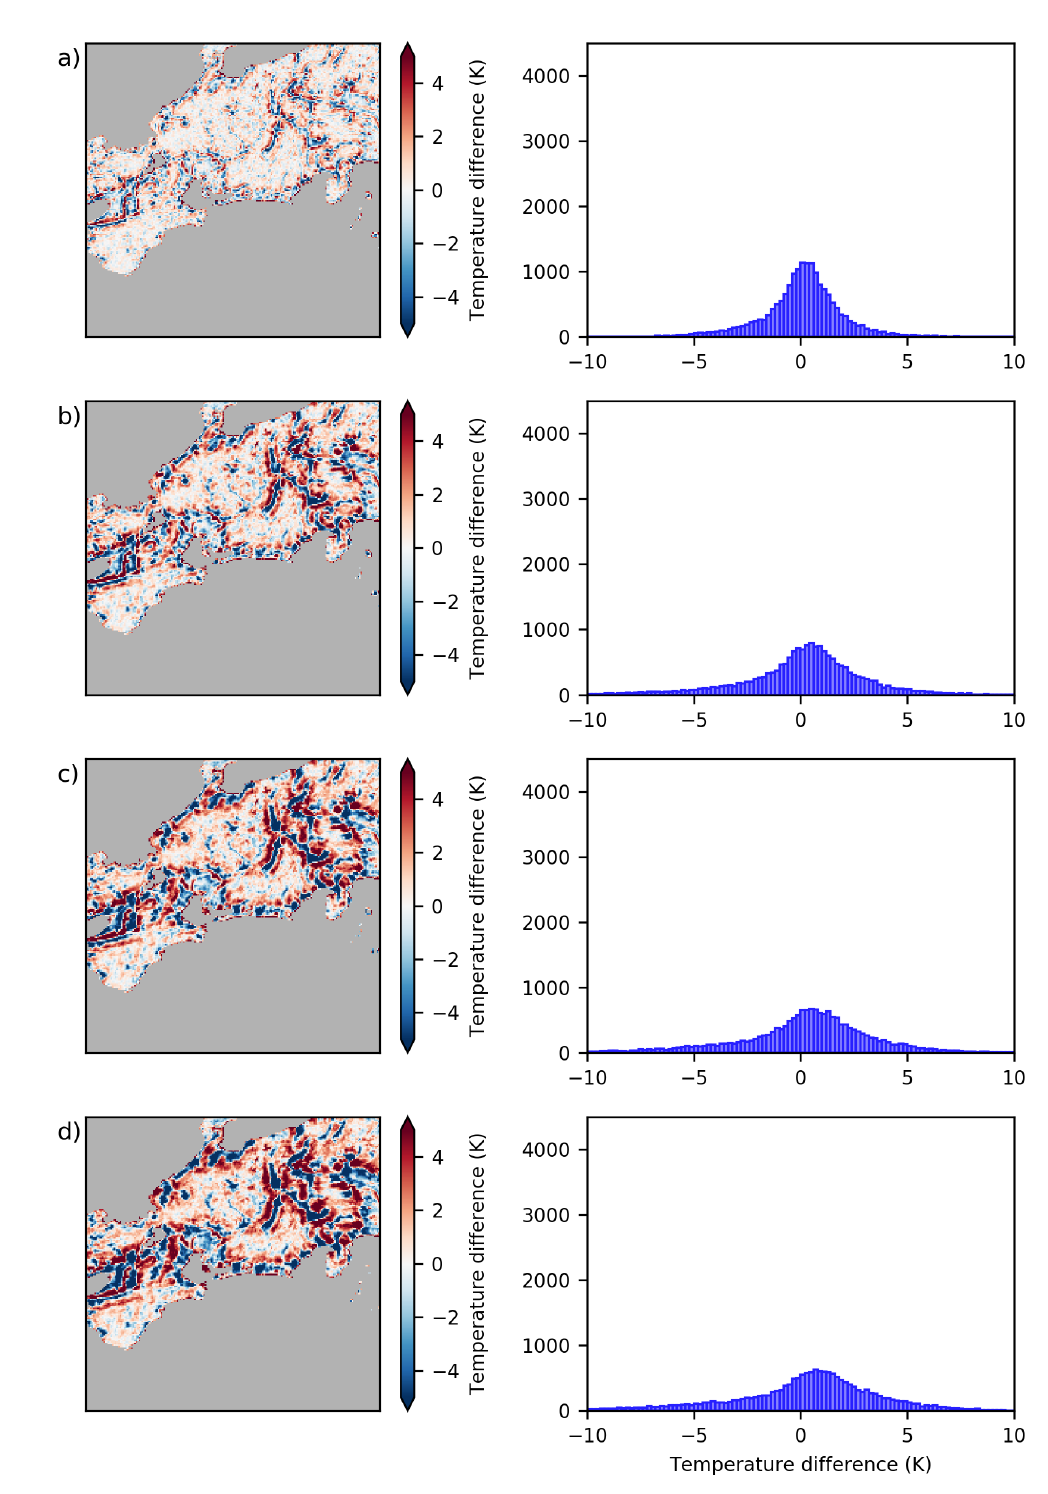
Figure A3. Changes in the spatial and statistical distribution of temperature estimates for the central Japan (jpn) study area by window size. Window levels shown are ( a ) 5 × 5 window; ( b ) 7 × 7 window; ( c ) 9 × 9 window; and ( d ) 11 × 11